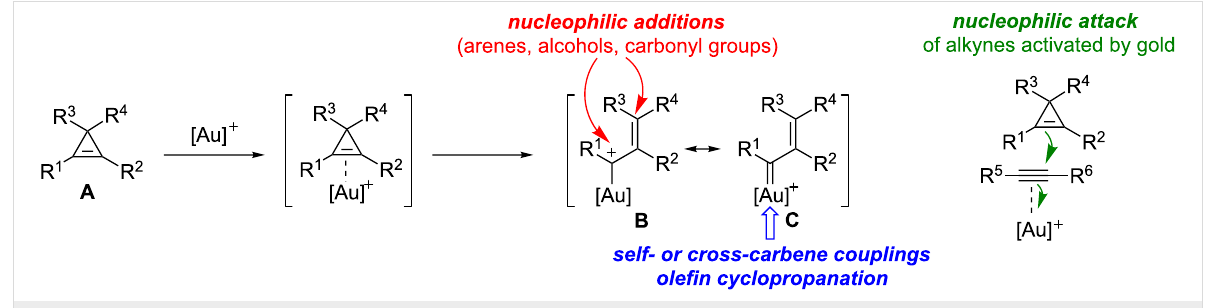
Scheme 1: General reactivity of cyclopropenes in the presence of gold